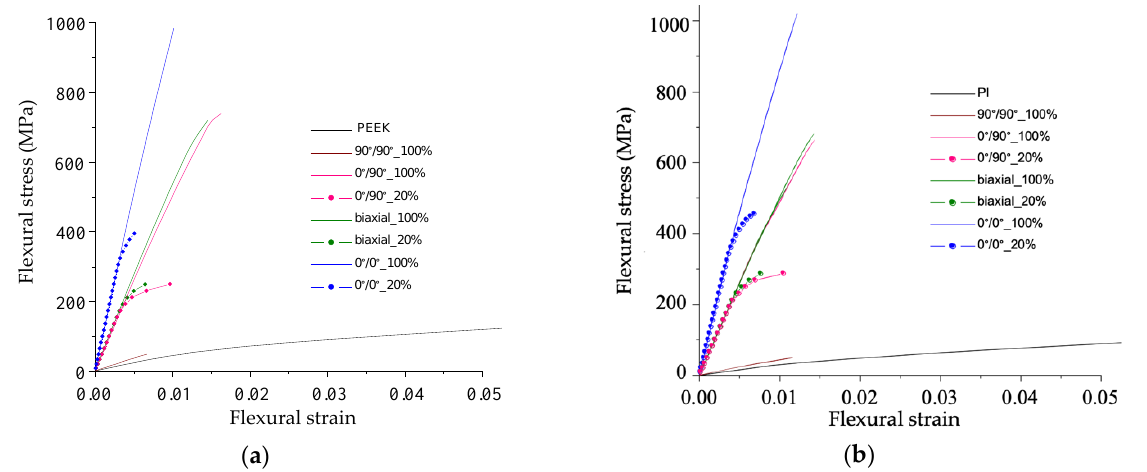
Figure 19. The flexural stress–strain curves for the PEEK- ( a ) and PI-based ( b ) composites with changing the CF layouts and adhesion levels (100% and 20%).